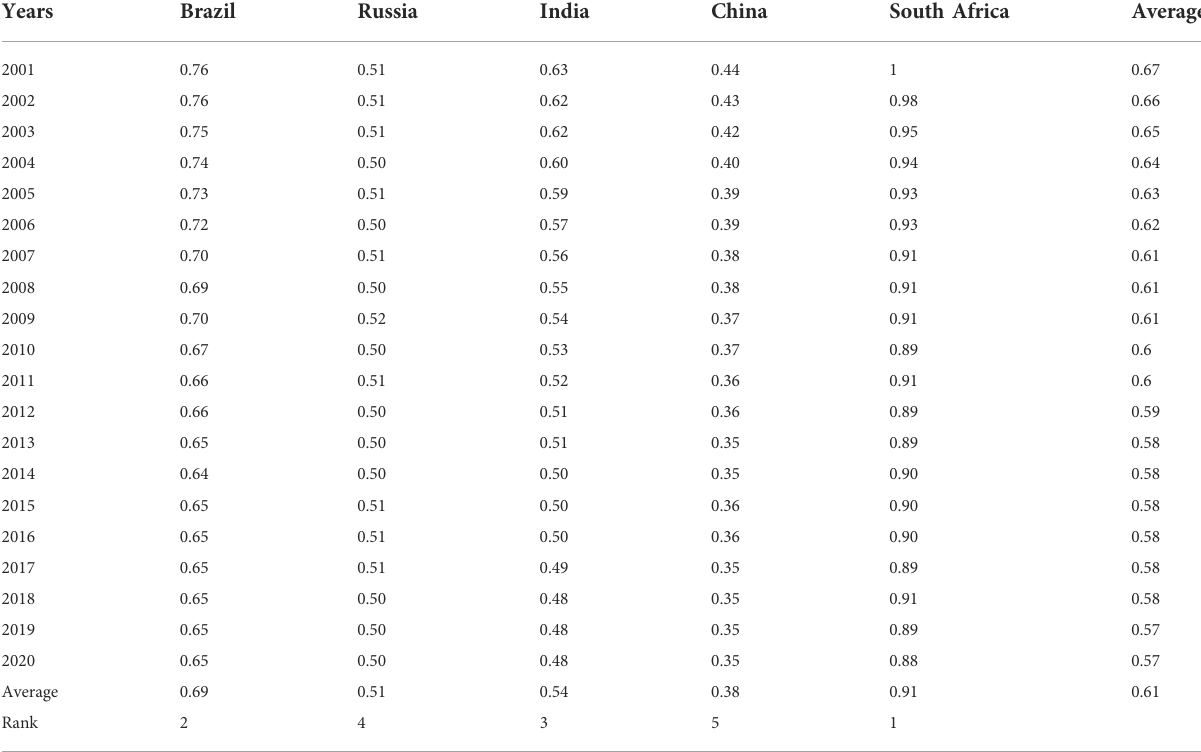
TABLE 4 Environmental Ef fi ciency score of energy consumption in BRICS